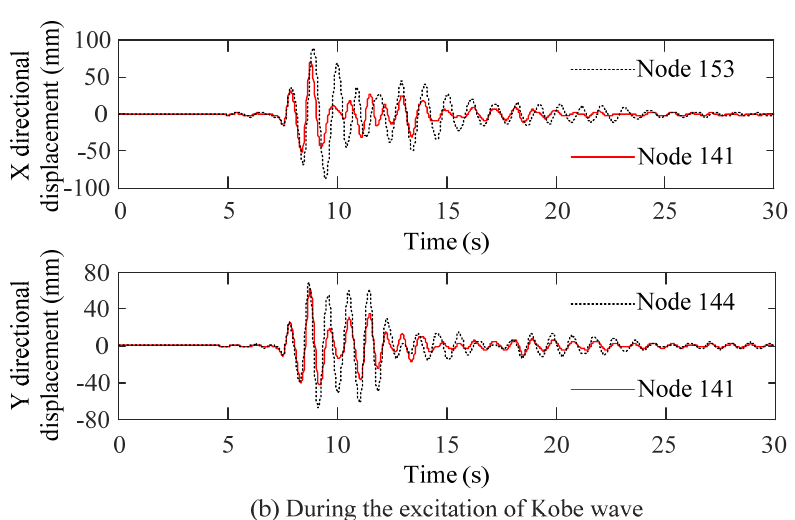
Figure 13. Contrasts of the horizontal displacement response of the top node of the structure without MRDs.